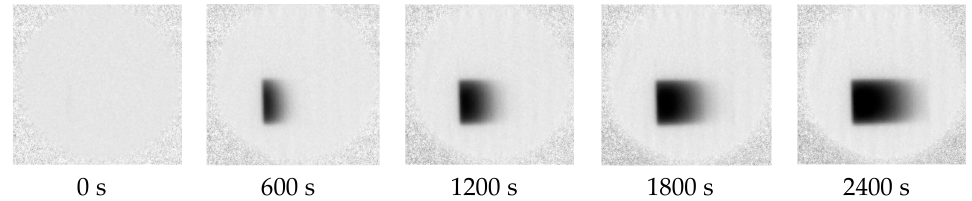
Figure 6. Image sequence of the hydrogen diffusion into Zry-4 at 1173 K .